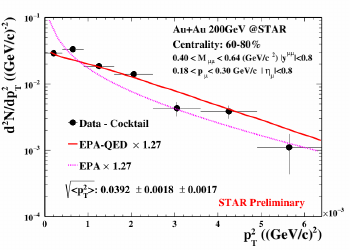
Figure 4: (color online) The p 2 distribution Figure 5: (color online) The ∆ φ distribution T of excess yield in the mass region of 0.40- of excess yield in the mass region of 0.40- 0.64 GeV / c 2 compared to the model calcula- 0.64 GeV / c 2 in 60-80% collisions very-low- p T ( p T < 0 . 10 GeV / c tions in 60-80% collisions.